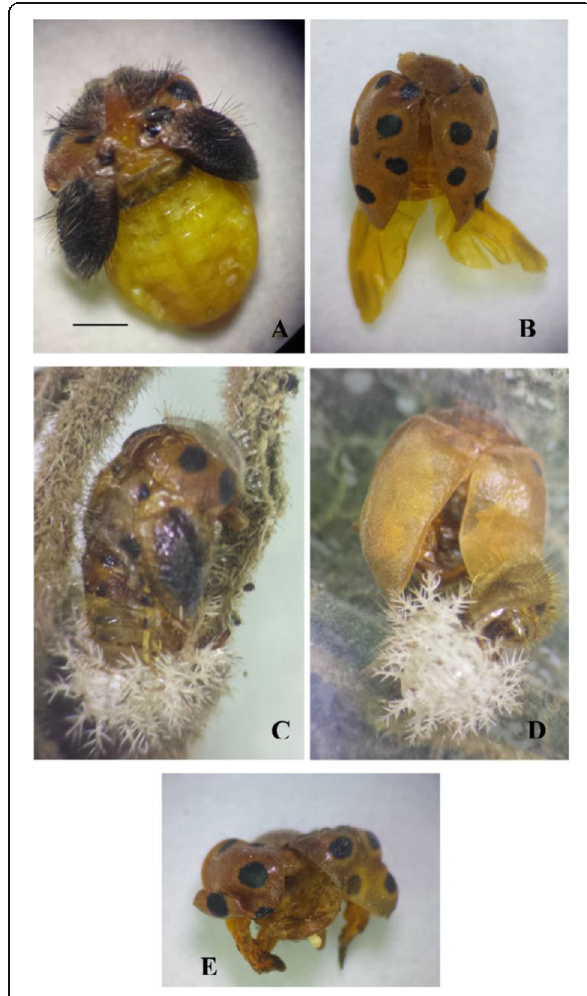
Fig. 5 Malformation in adults emerged from treated pupae with